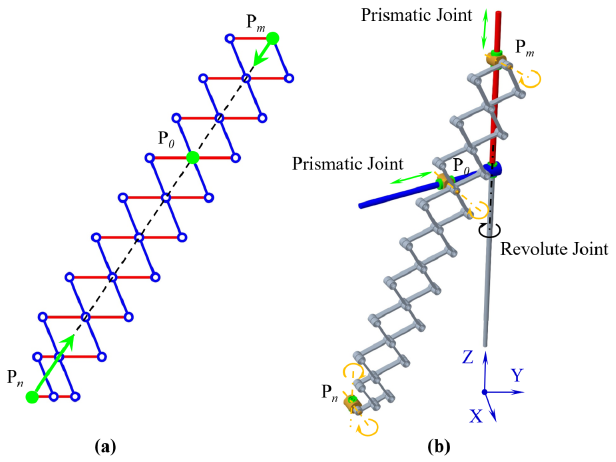
Figure 3. Compensation mechanism combining ( a ) pantographs and ( b ) the 2R1T architecture.